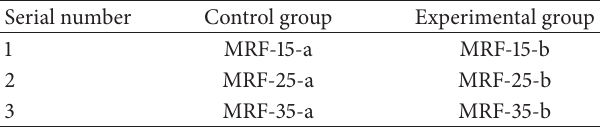
Table 2: The groups of MRF samples in the wear